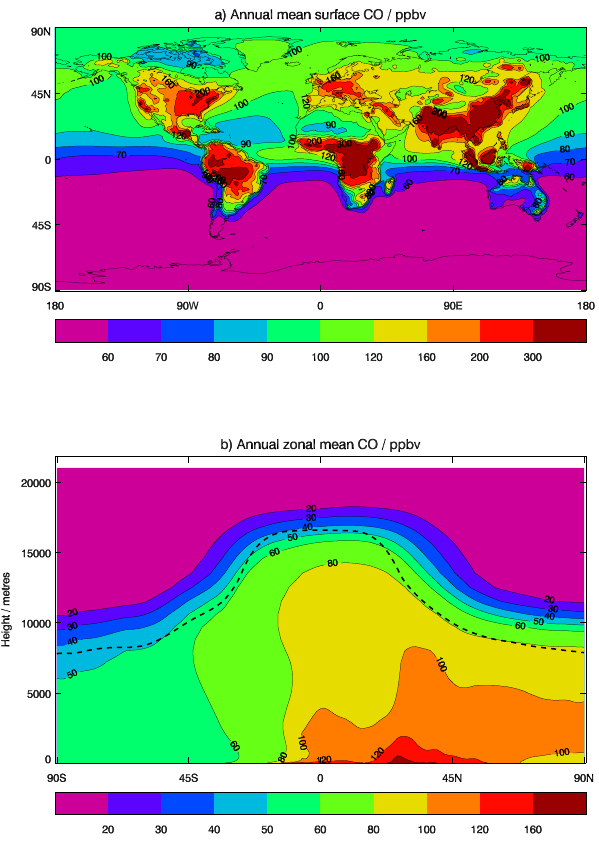
Fig. 15. Multi-annual (a) surface and (b) zonal mean CO distributions from the StdTrop chemistry scheme in the tropospheric configuration of the UKCA model. The thick dashed line in (b) marks the position of the modelledtropopause(Hoerlingetal.,1993).